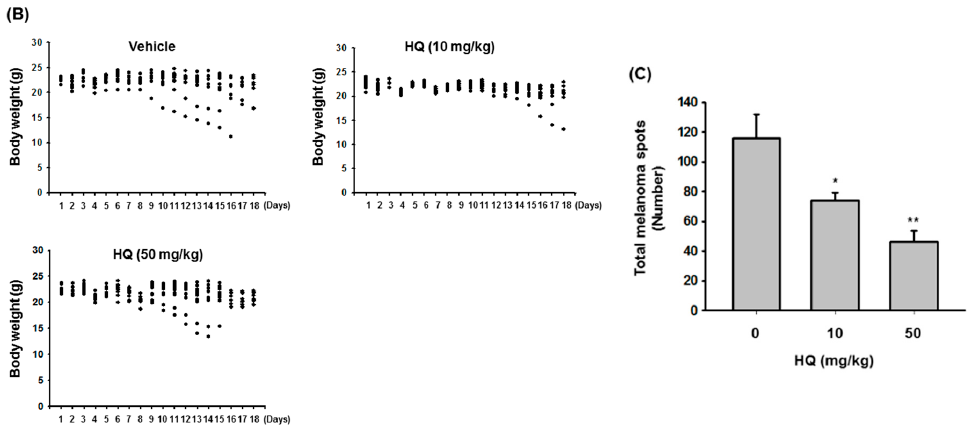
Figure 5. Effect of HQ on the lung metastasis of B16F10 melanoma . ( A ) Schematic diagram of in vivo lung metastasis model. ( B ) The body weight of B16F10 melanoma lung metastasis mice treated with either vehicle or the indicated doses of HQ was measured every day for 18 days. ( C ) B16F10 melanoma lung metastasis mice treated with either vehicle or the indicated doses of HQ were euthanized at day 19. After euthanasia, the lungs of the mice were excised and the total number of melanoma spots in the lungs of each group was counted and plotted. * p < 0.05 and ** p < 0.01 compared to the vehicle control.